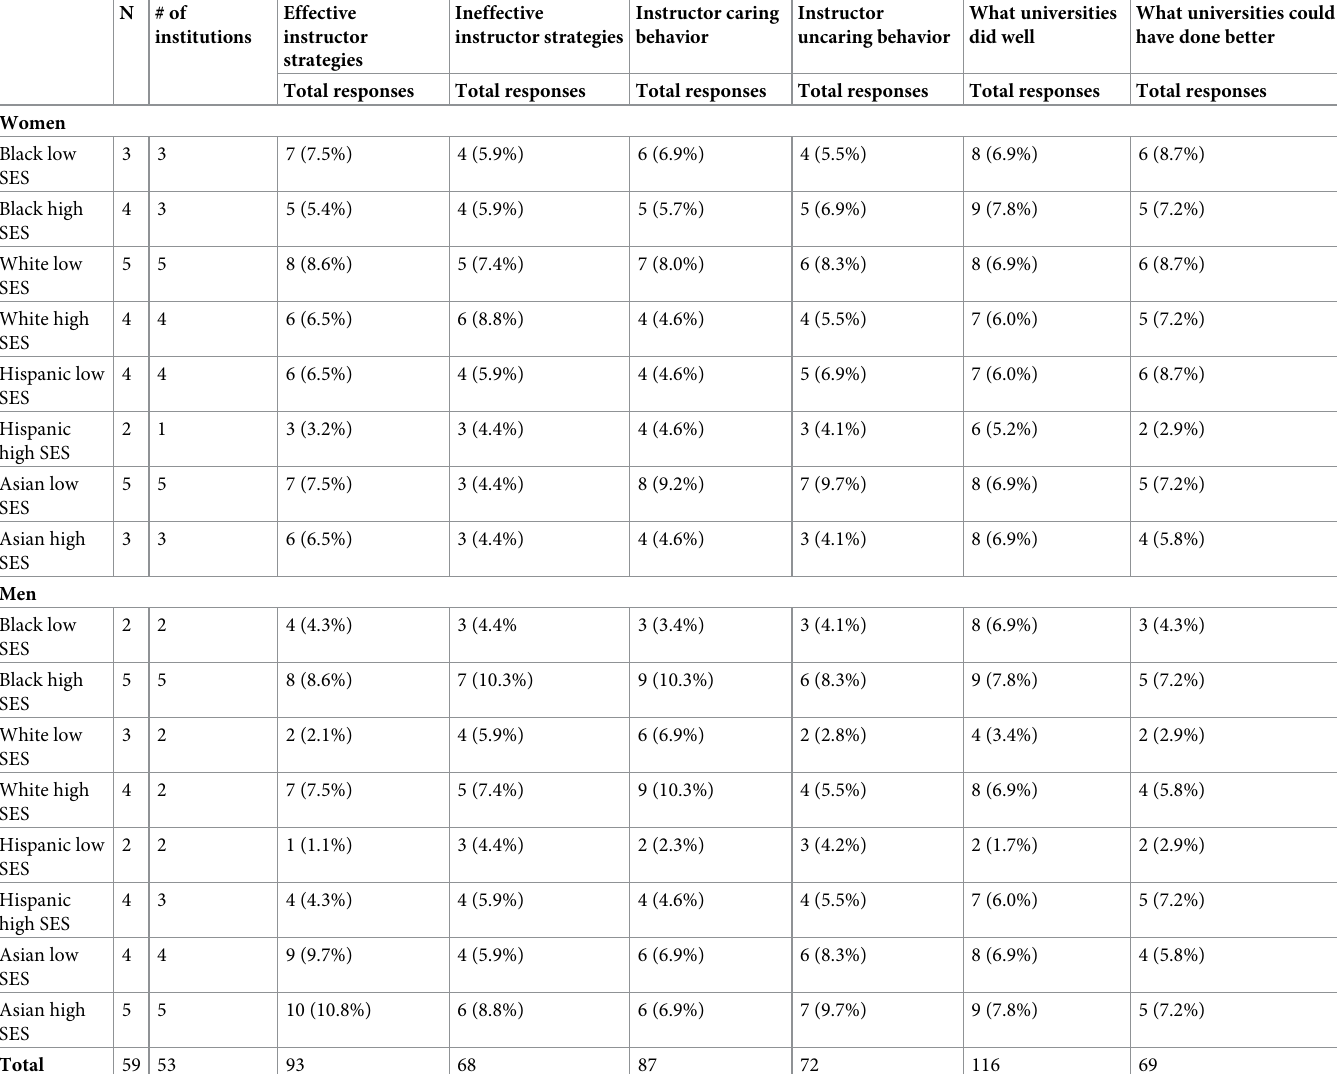
Table 2. Characteristics of focus groups and distribution of responses by